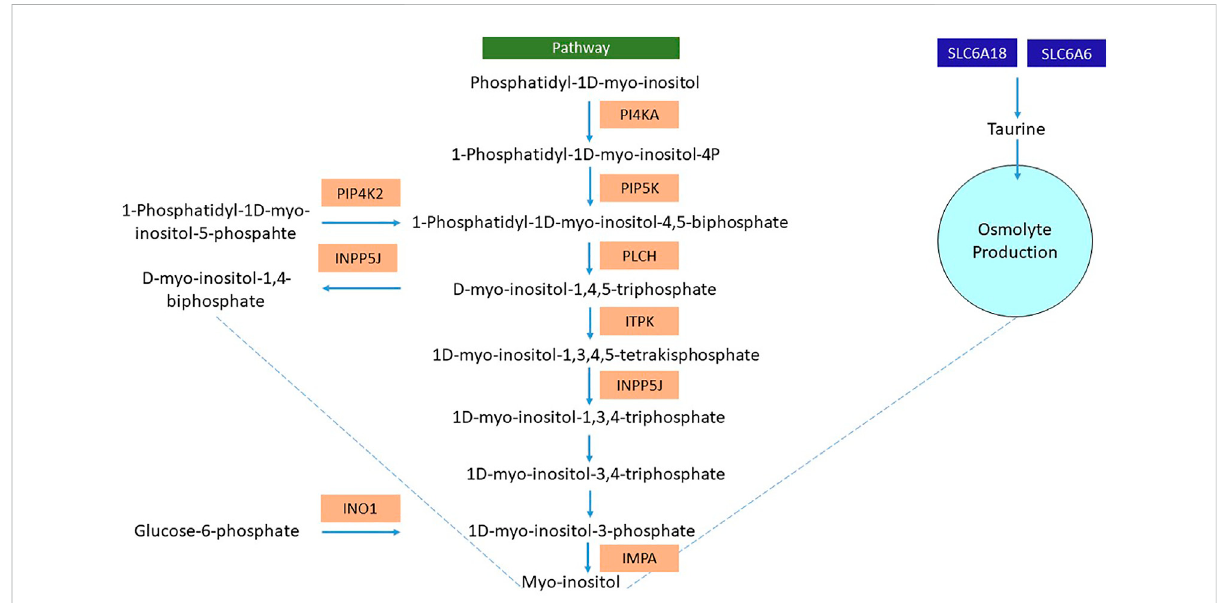
FIGURE 10 Representative fl owchart of differentially expressed genes (highlighted in orange) involved in the osmolyte production (myo-inositol and taurine)ofthe L.rohita kidneyaftertransferringtoahighsaltconcentration.PI4KA, phosphatidylinositol4-kinasealpha;PIP5K, phosphatidylinositol- 4-phosphate 5-kinase; PLCH, phospholipase C-like protein; ITPK, inositol trisphosphate 3-kinase; INPP5J, phosphatidylinositol 4,5-bisphosphate- 5-phosphatase; PIP4K2, phosphatidylinositol 5 phosphate-4-kinase; INO1, inositol-3-phosphate synthase; SLC6A6, solute carrier family 6 member 6; SLC6A18, solute carrier family 6 member